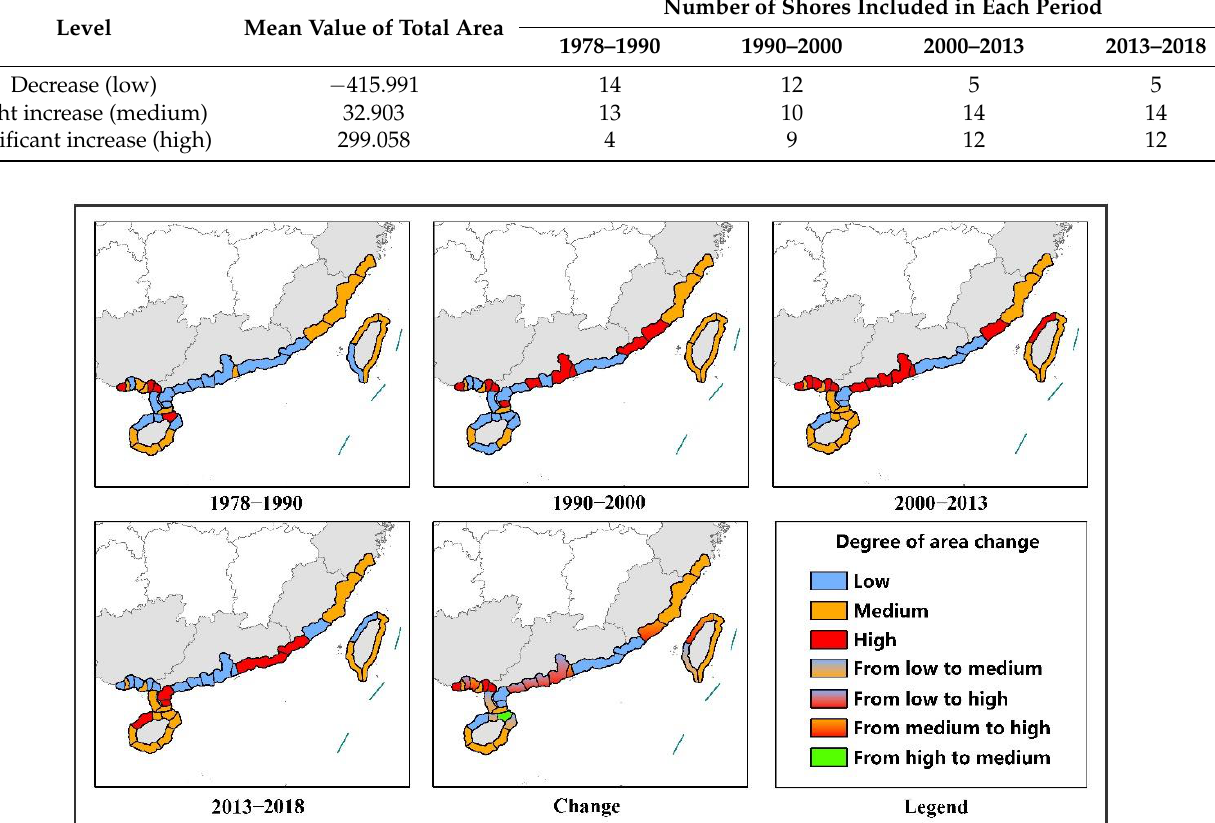
Figure 3. Temporal and spatial variations in the total area. In the legend, the low level indicates a decrease in area, the “Medium” level indicates a slight increase in area, and the high level indicates a significant increase in area.